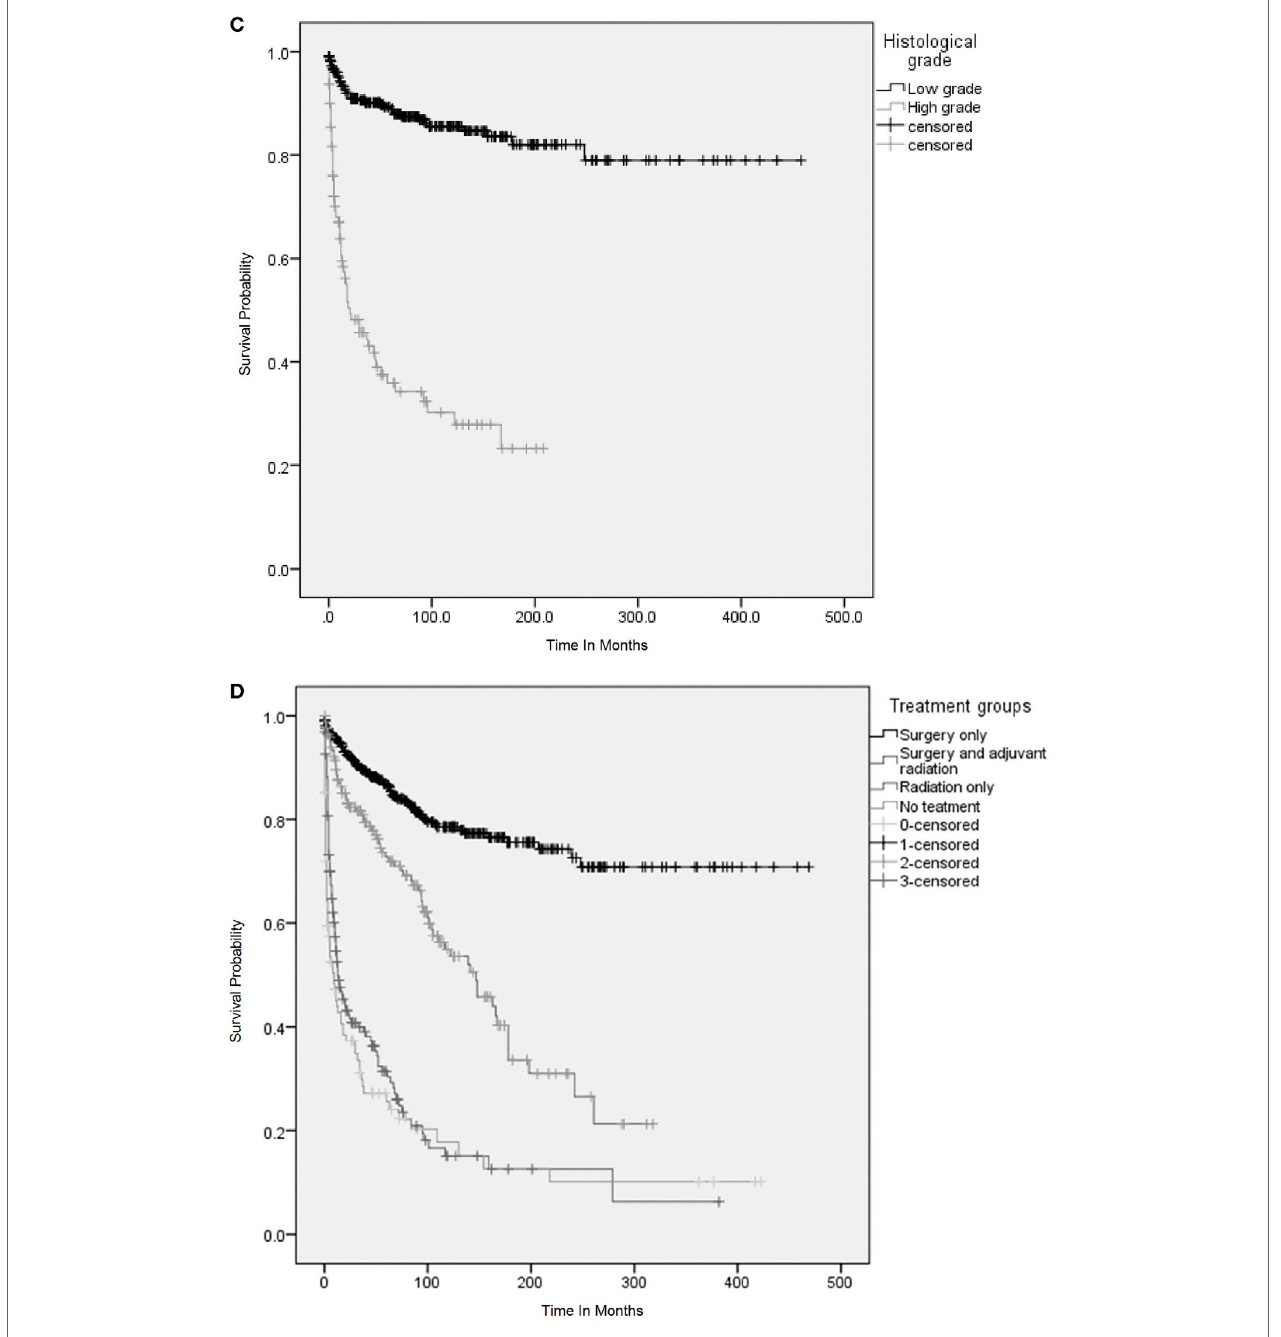
FigUre 3 | Overall survival (OS) was analyzed using Kaplan–Meier (KM) method and censored patients are indicated by vertical lines on the KM curves. (a) KM survival curves among patients with primary adenoid cystic carcinoma (ACC) and mucoepidermoid carcinoma (MEC) of lung according to the period of diagnosis. (B) KM survival curves according to stage (Surveillance Epidemiology and End Results staging) at diagnosis of primary AEC and MEC of lung. (c) KM survival curves according to the histological grades at diagnosis of primary ACC and MEC and (D) KM survival curves according to the treatment received. (a) OS was significantly higher among patients who were diagnosed during 2000–2014. Log rank p < 0.001. (B) OS among patients with localized disease was significantly higher as compared to patients with regional and distant metastasis. Log rank p < 0.001. (c) OS among patients with histologically low-grade disease was significantly higher as compared to patients with high-grade disease. Log rank p < 0.001. (D) OS among patients who underwent surgery only and adjuvant radiation was significantly higher as compared to patients who received only radiation or received no treatment. Log rank p <